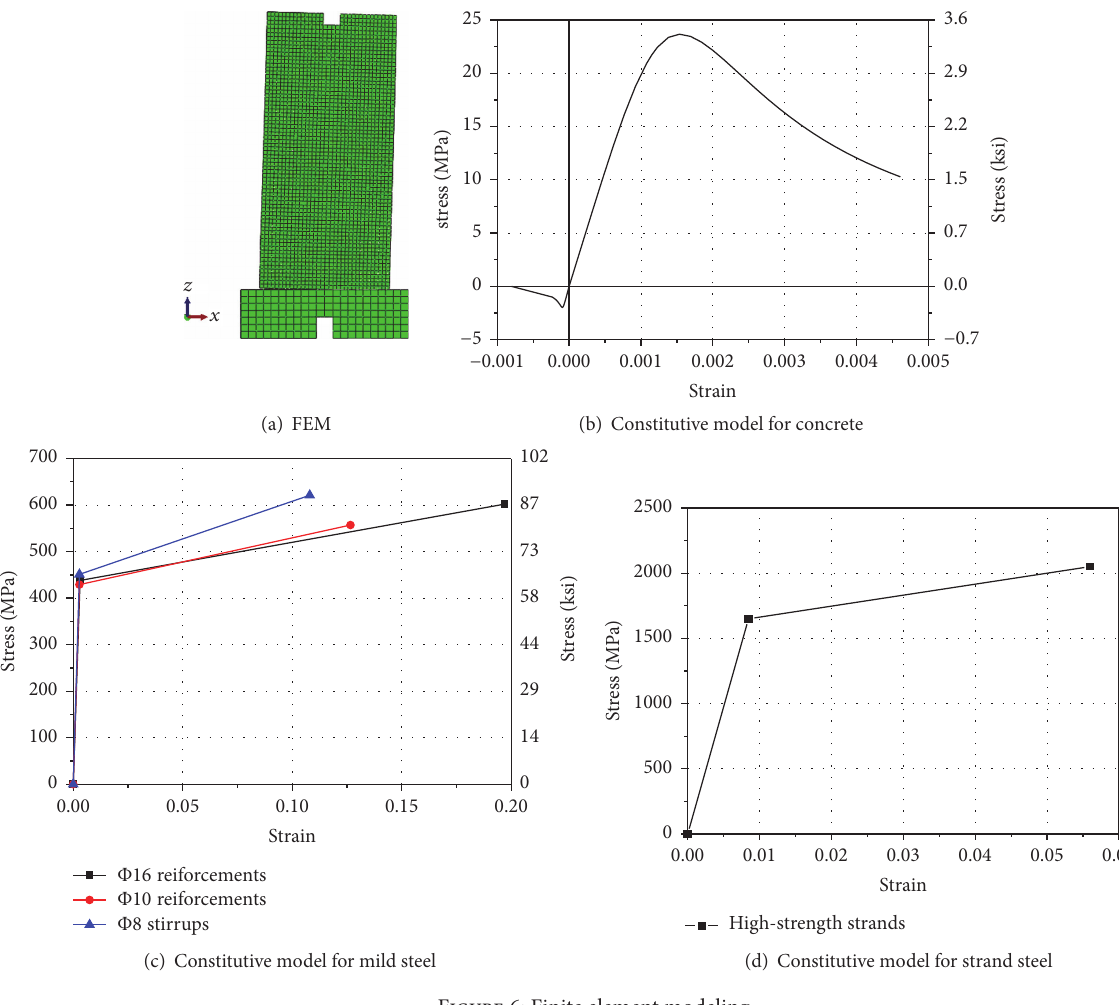
Figure 6: Finite element modeling.